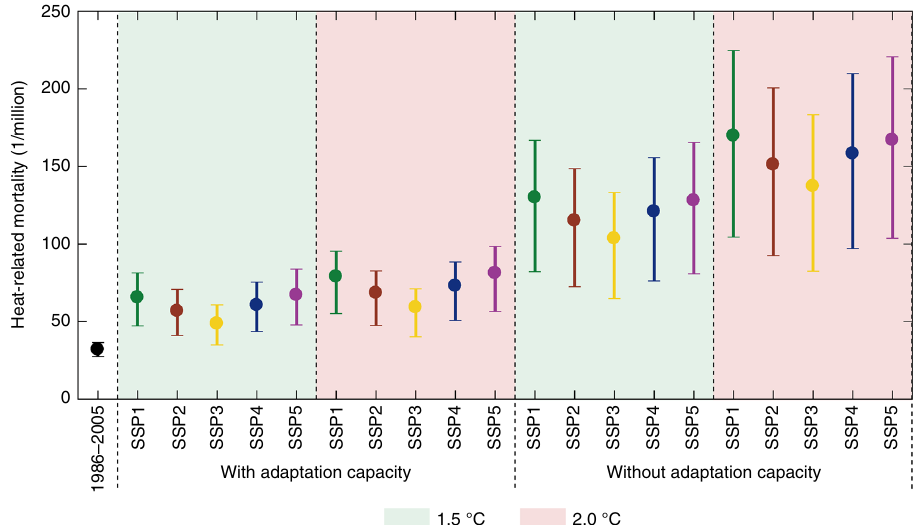
Fig. 2 Comparison of annual heat-related mortality at 1.5 °C and 2.0 °C global warming under SSPs and the reference period (1986 – 2005). Future projection of mortality considers two scenarios — with and without improved adaptation capacity. Dots and straight lines denote the ensemble mean and range of mortality estimated by multiple GCMs. Source data are provided as a Source Data fi le